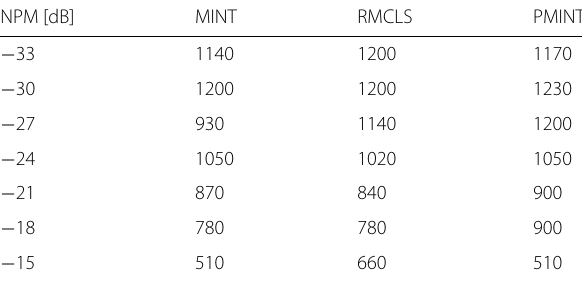
Table 5 Optimal intrusively determined reshaping filter length L opt g for MINT, RMCLS, and PMINT for acoustic system S 1 and